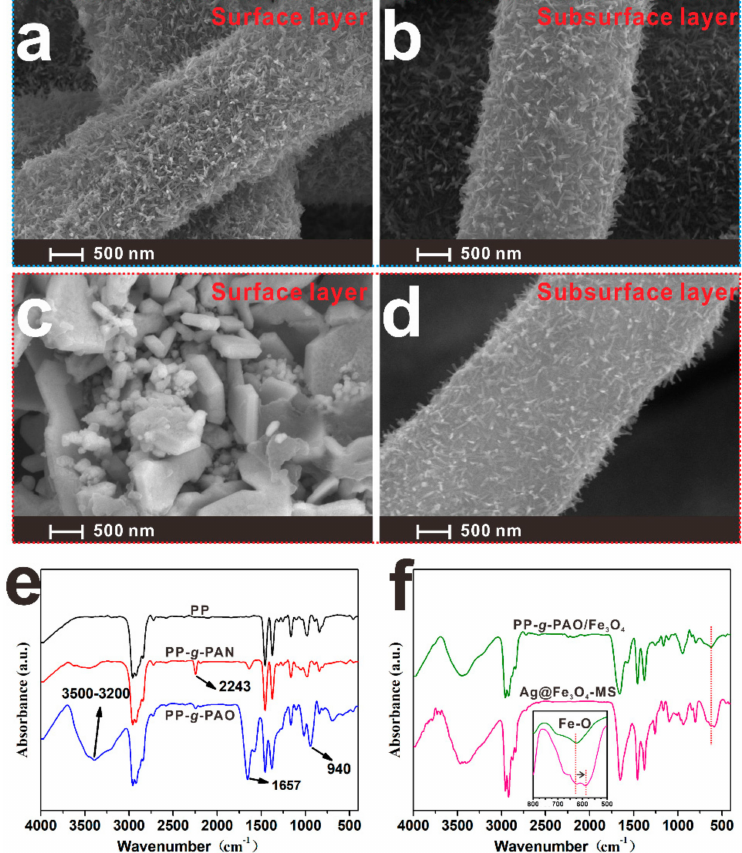
Figure 2. SEM images of ( a , b ) PP- g -PAO / Fe 3 O 4 and ( c , d ) Ag@Fe 3 O 4 -MS. ( e , f ) Fourier transform infrared (FTIR) spectra of PP, PP- g -PAN, PP- g -PAO, PP- g -PAO / Fe 3 O 4 and Ag@Fe 3 O 4